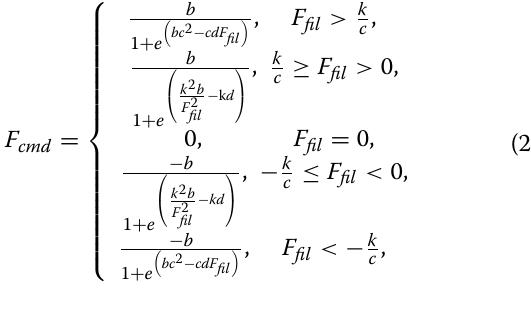
x -axis with the green lines while the blue, cyan and red lines show the filter results when M = 30 , M = 70 and M = 100 .